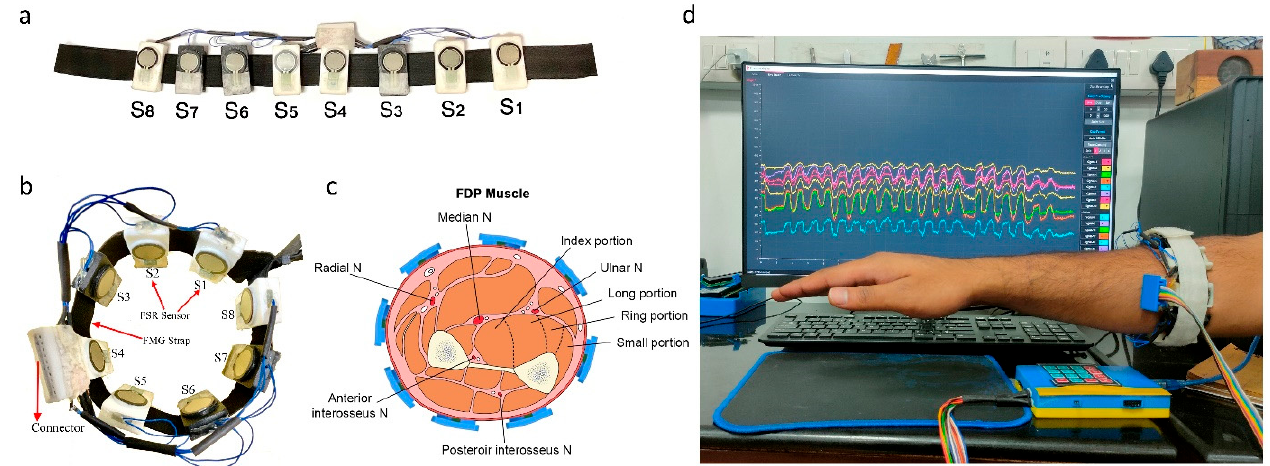
Figure 2. Data collection setup. ( a ) Force myography band using an array of eight FSR sensors, 3D printed mounts, and elastic strap, ( b ) FMG band sensor placement sites on the forearm, ( c ) forearm cut section depicting sensor placement sites with respect to muscles, and ( d ) FMG band donned on the forearm and data recording.